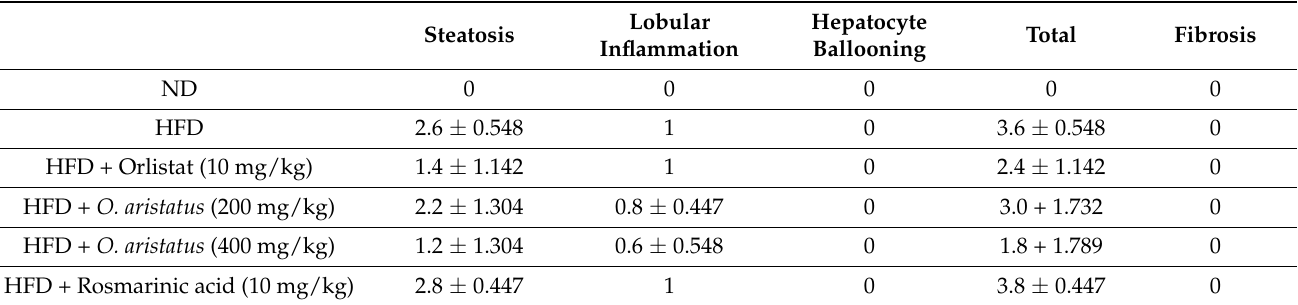
Table 4. NAFLD activity scoring (NAS) of the liver tissues.